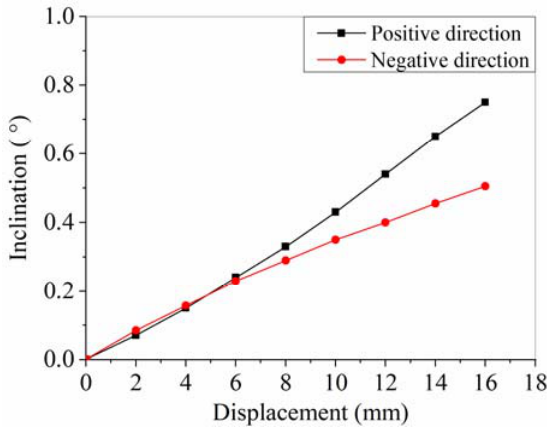
Figure 24. Relationship between inclination and displacement of the abutment.